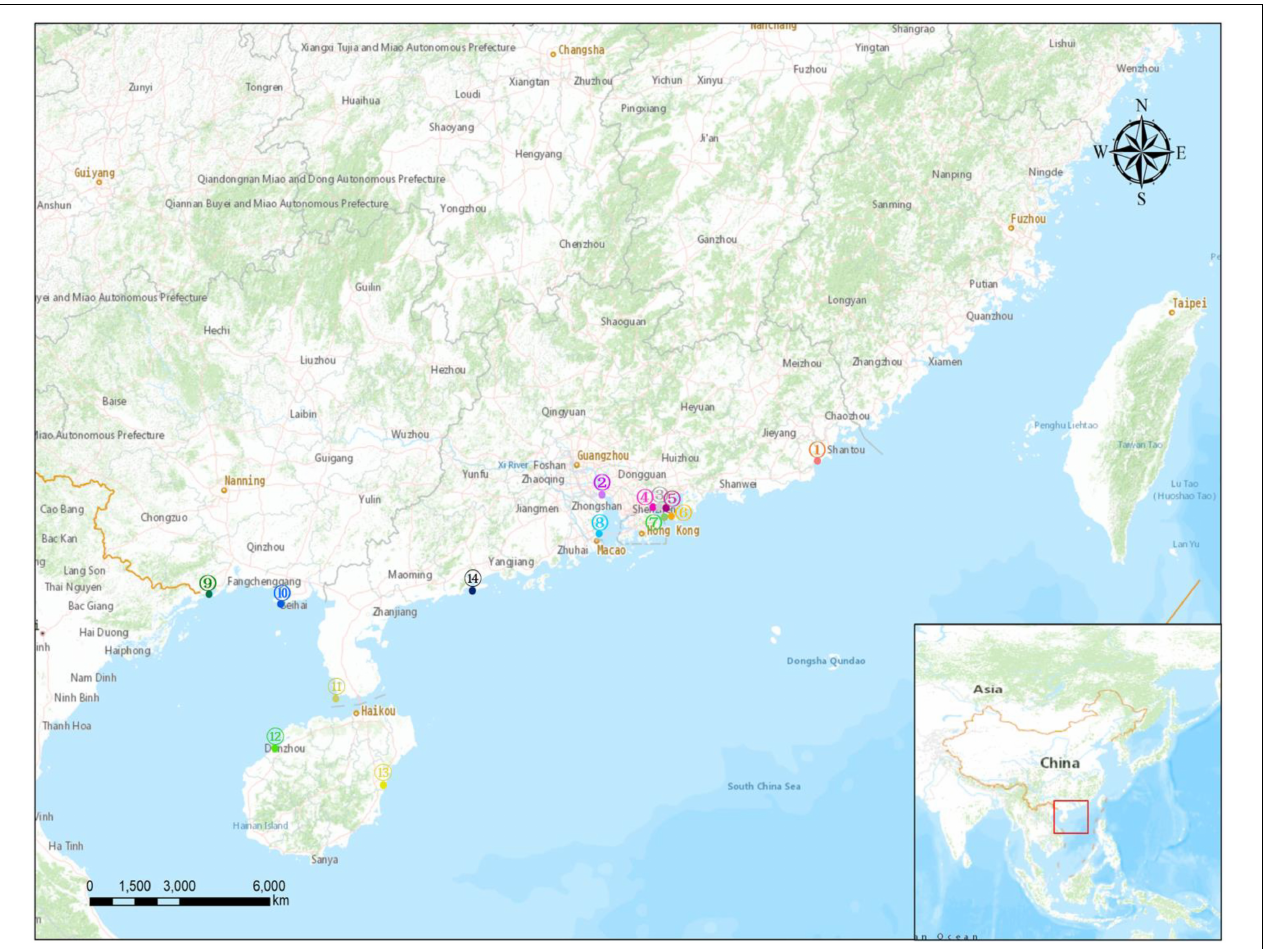
FIGURE 1 | Map showing the locations of the 14 sampled beaches. Detailed information for each sampling site is given in Supplementary Table 1 .